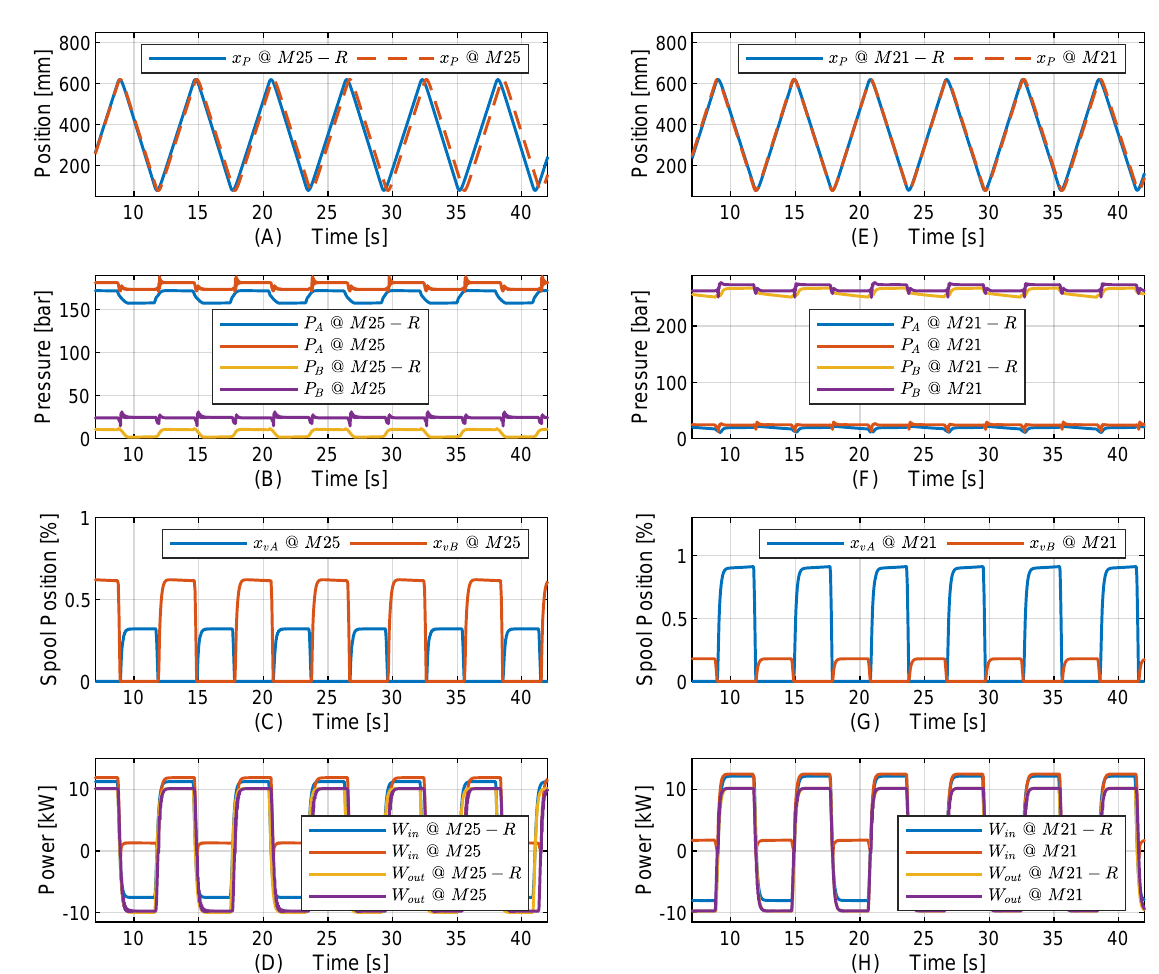
Figure 10. Simulation results for the DPDS and DPDS-R drive architectures. ( A – D ) Depict the results for M25, M25-R, and ( E – H ) depict the results for M21,